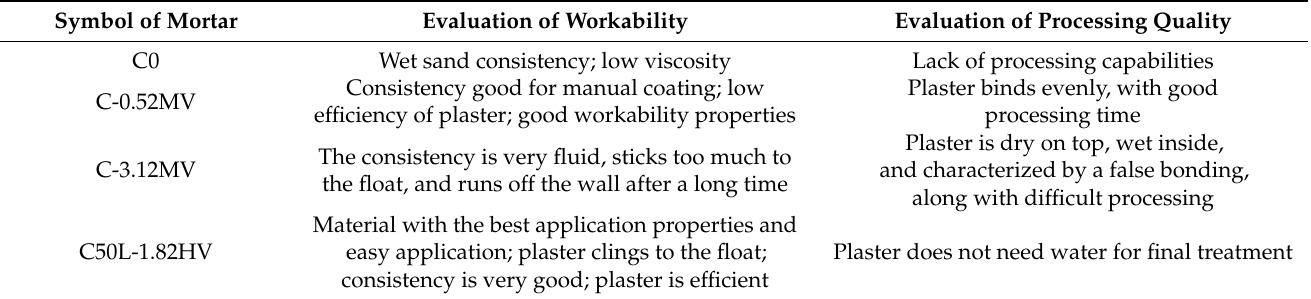
Table 10. Descriptive assessment of the workability of selected mortars.